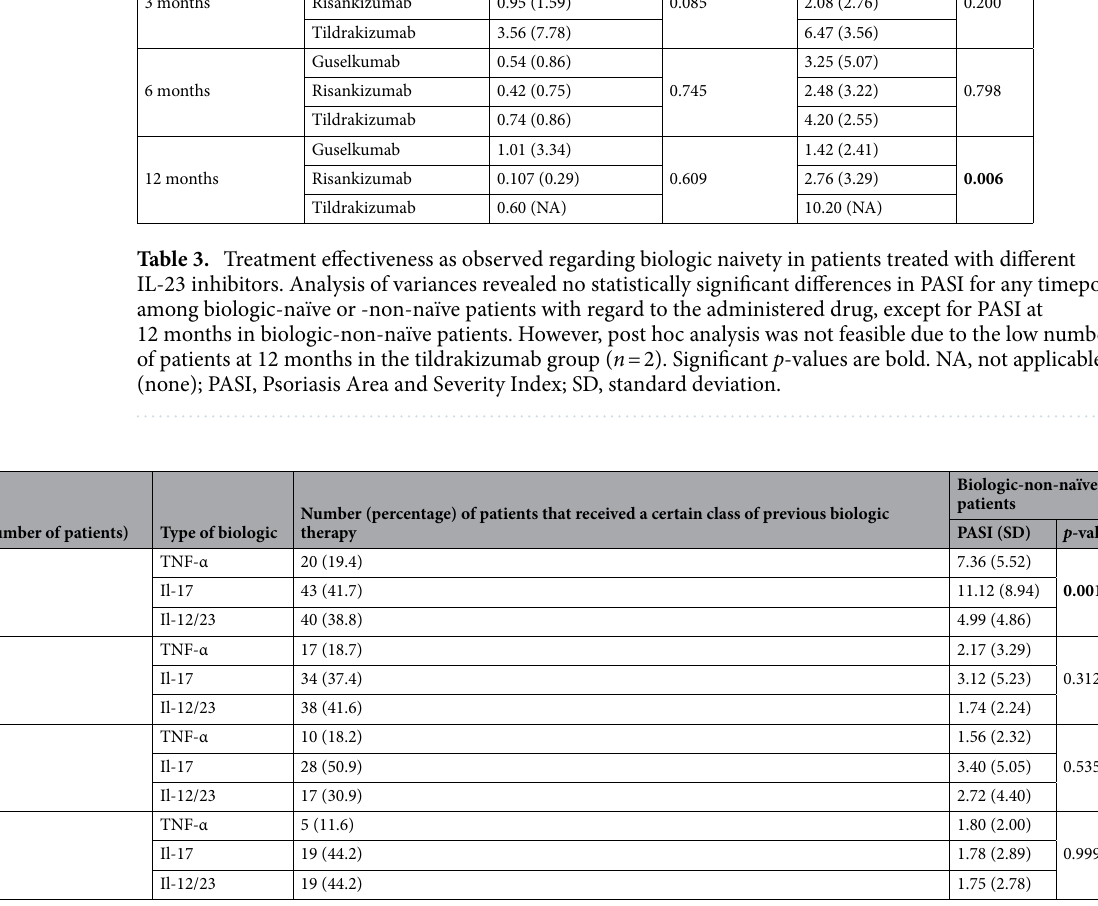
Table 4. Treatment effectiveness as observed with regard to class of previous biologic therapy. Analysis of variances revealed statistically significant differences in disease severity (as measured in PASI) regarding the class of previous biologic treatment at baseline. Post hoc analysis results show significantly higher PASI in patients treated with IL-17 inhibitors as compared to those treated with IL-23 inhibitors ( p < 0.001), but not TNF- α inhibitors ( p = 0.147). There was no difference regarding PASI at baseline between TNF- α inhibitors and IL-12/23 inhibitors at baseline ( p = 0.655). Significant p -values are in bold. IL, interleukin; PASI, Psoriasis Area and Severity Index; SD, standard deviation; TNF, tumour necrosis